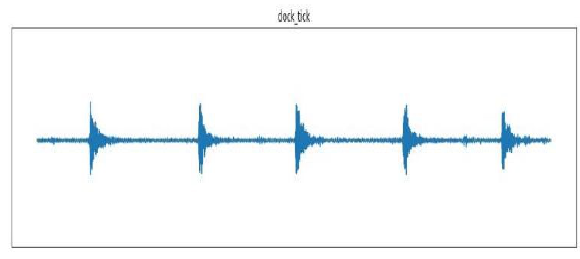
Fig. 5. Dog Spectrogram.